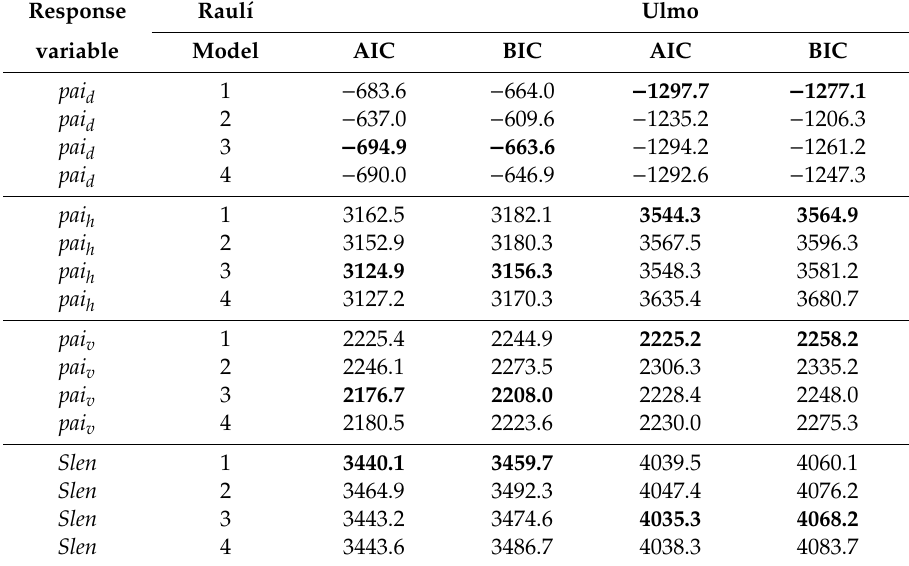
Table 3. Akaike’s (AIC) and Bayesian information criterion indices (BIC) of the fitted mixed-e ff ects models by the response variables and species. The best-supported model for each variable is presented in bold